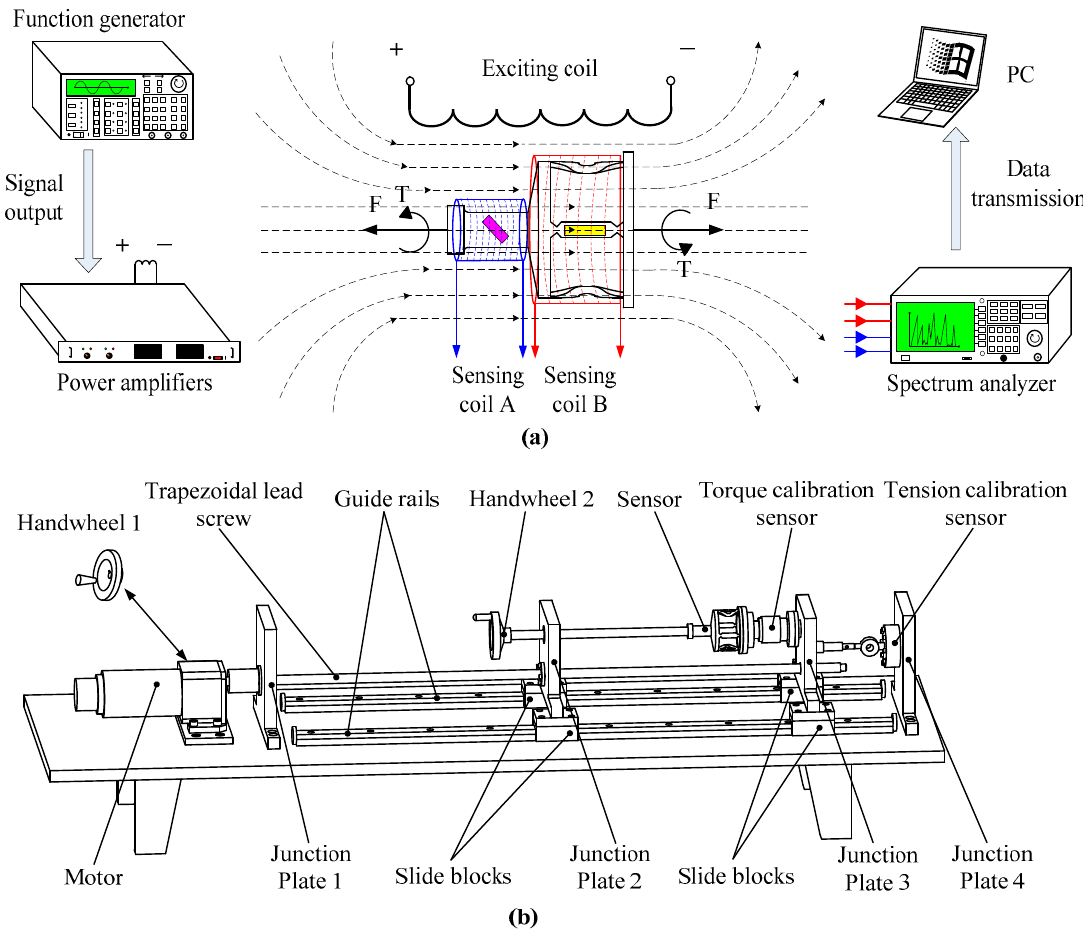
Figure 7. The experiment device schematic diagram: ( a ) method for the output performance experiments and ( b ) the schematic diagram of the loading platform. PC, personal computer.